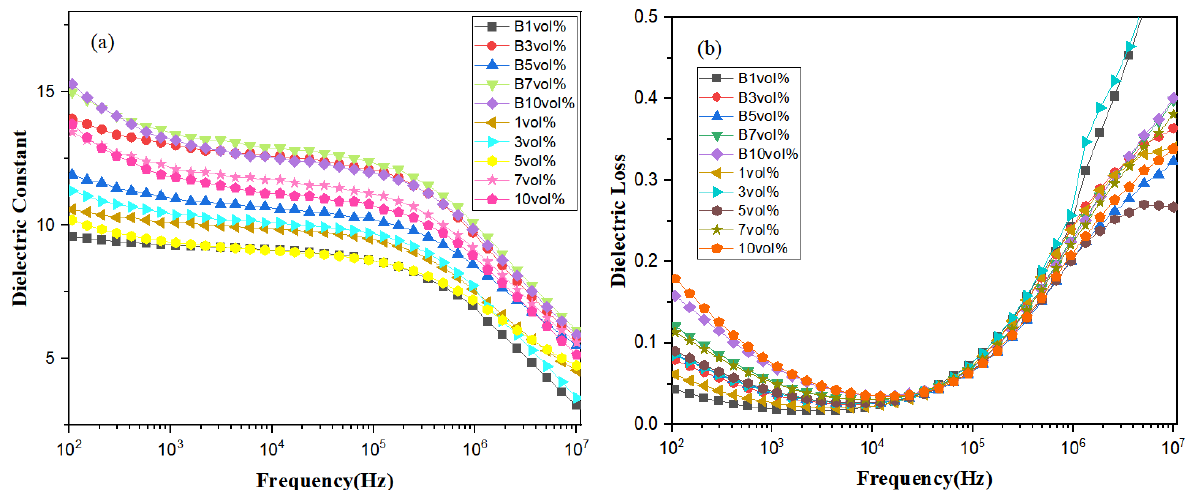
Figure 7. Dielectric constant ( a ) and dielectric loss ( b ) for 7FO/PVDF nanocomposite films with different doping